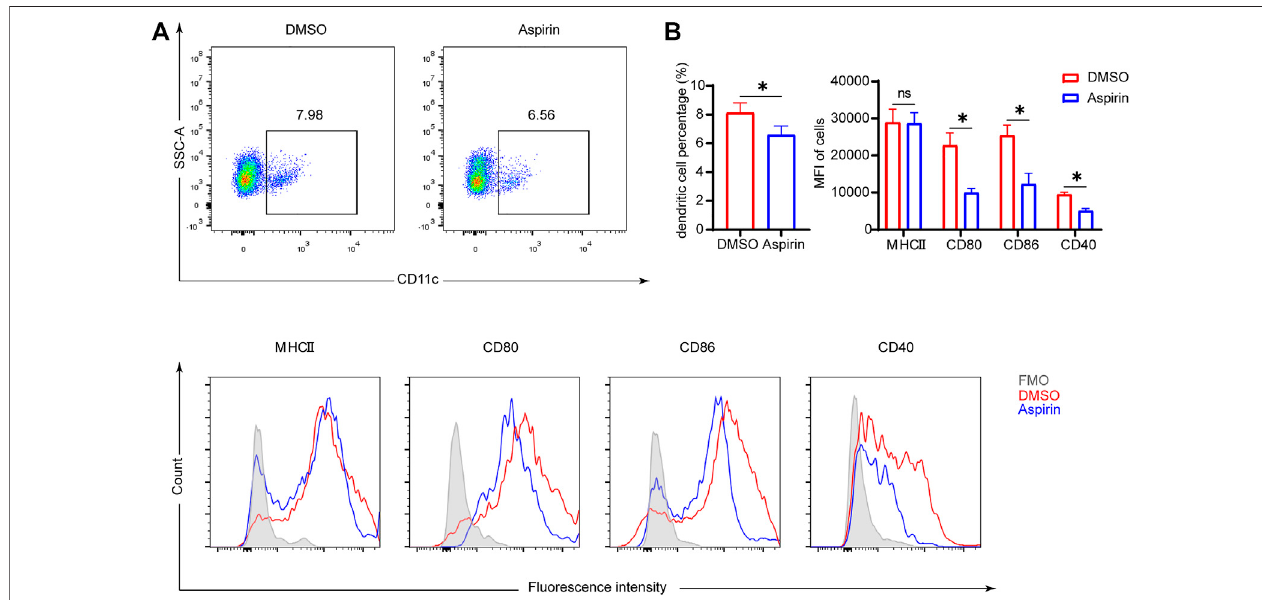
FIGURE 3 | Aspirin inhibits the maturation of DCs in the spleen of mouse after heart transplantation. On the seventh day after transplantation, spleens were collectedfromeachgroupandsplenocyteswereisolated.Fluorescence-conjugatedanti-MHCII,CD80,CD86,andCD40antibodieswereusedtodetecttheexpression level of molecules on DCs. DCs were identi fi ed by anti-CD11c antibody. (A) The proportion of CD11c (+) dendritic cells was displayed (top), and the expression levels of MHCII,CD80,CD86,andCD40onDCswereshown byMFIinhistograms(bottom). (B) ThepercentagesofDCsinspleen(left)and theexpression levelsofMHCII, CD80, CD86, and CD40 on DCs ofeach group (right). Data arepresented asthe mean ± SD offour independent experiments. * p < 0.05; MHC, major histocompatibility complex; MFI, mean fl uorescence